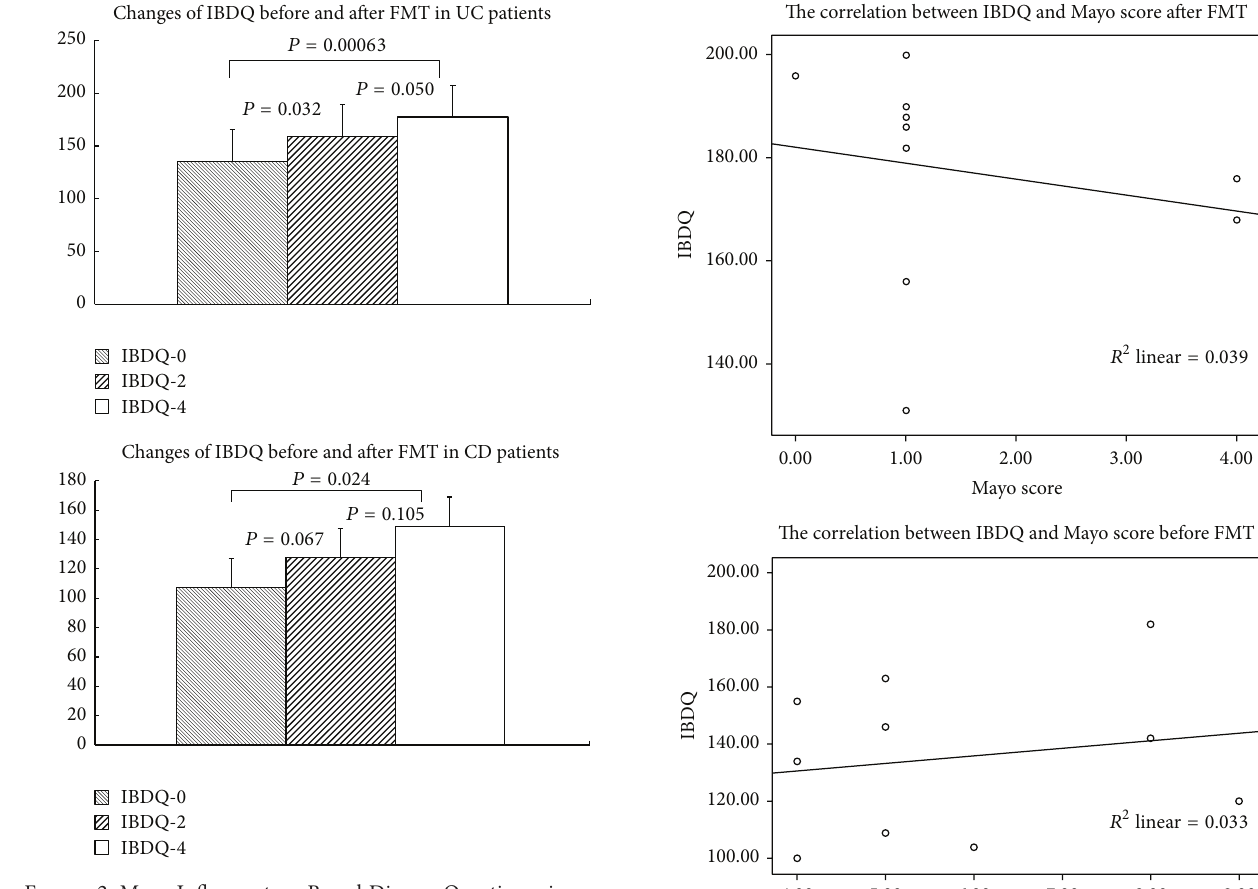
Figure 2: Mean Inflammatory Bowel Disease Questionnaire score before and after two and four weeks fecal microbiota transplanta- tion.